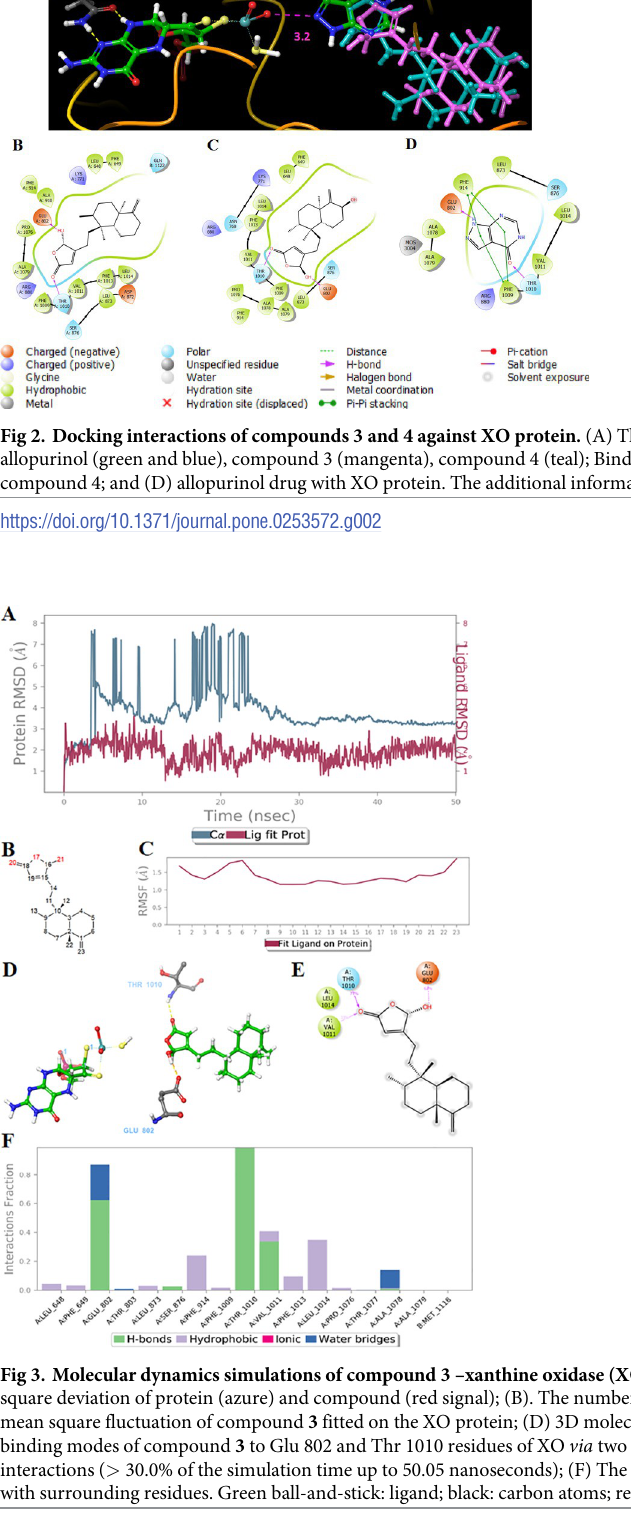
PLOS ONE | https://doi.org/10.1371/journal.pone.0253572 June 30,